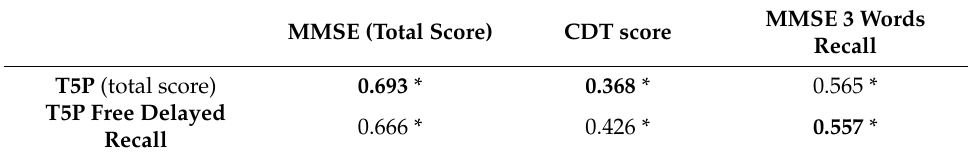
Table 4. Correlation between T5P, CDT and MMSE scores.